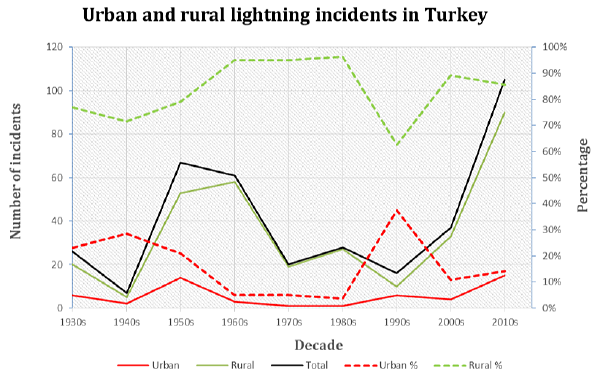
Figure 13. Number and percentage of urban and rural lightning incidents in Turkey by decade between the 1930s and the 2010s (“2010s” include data from January 2010 to the end of June